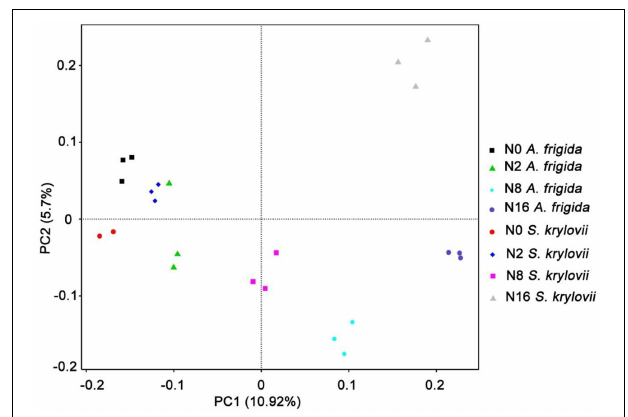
FIGURE 4 | Principle component analysis (PCA) of microbial communities based on OTUs for all samples from S. krylovii and A. frigida rhizosphere. The first two components were 10.68% and 5.46%, respectively.